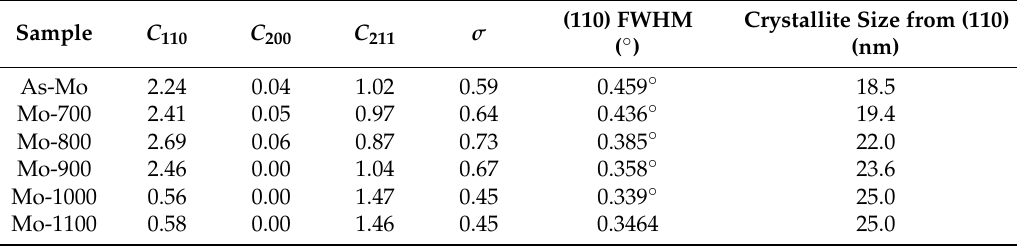
Table 1. Summary of texture coefficient, preferred orientation, (110) full width at half maximum (FWHM), and crystallite size, calculated from the (110) peak of Mo thin films, as a function of annealing